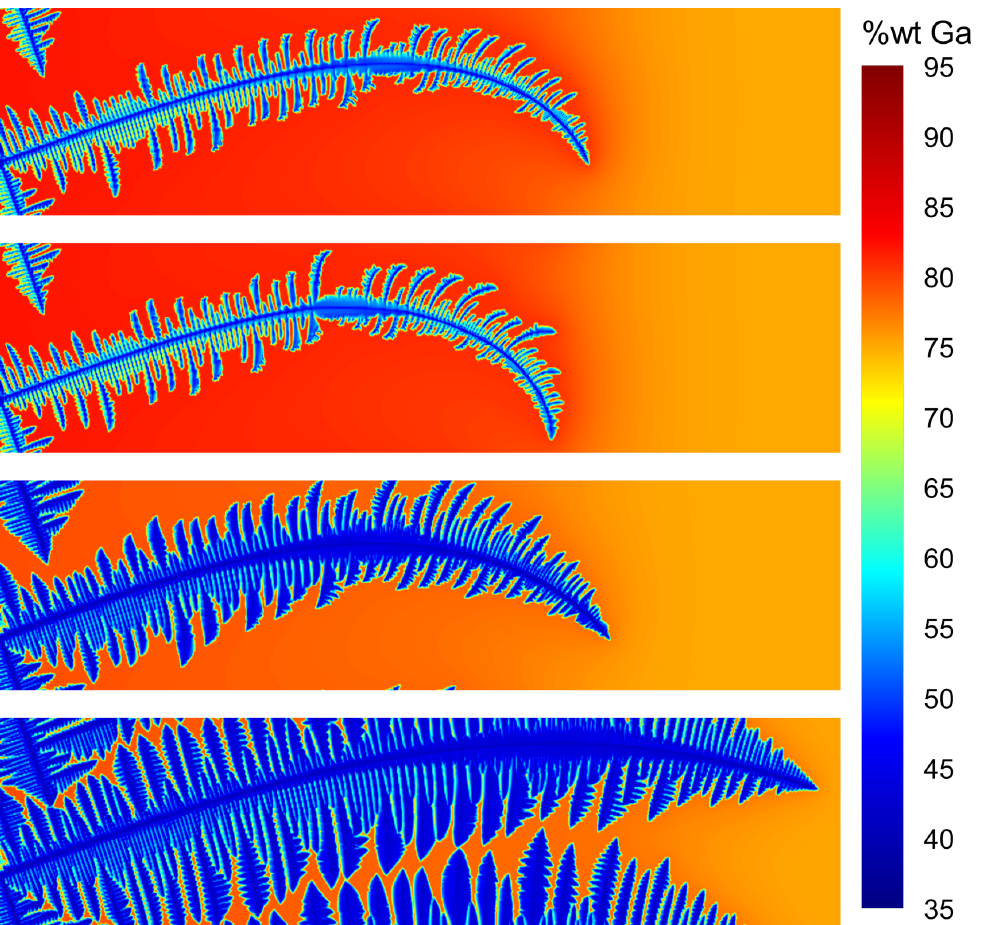
Figure 5. Concentration profiles of dendrites grown under a constant force using different modelling assumptions at the end of the final time 800 s/1600 s (3D/2D). In descending order results correspond to the following modelling assumptions: 2D with plain strain; 2D with plane stress; 3D in a thin sample; 3D in a normal width